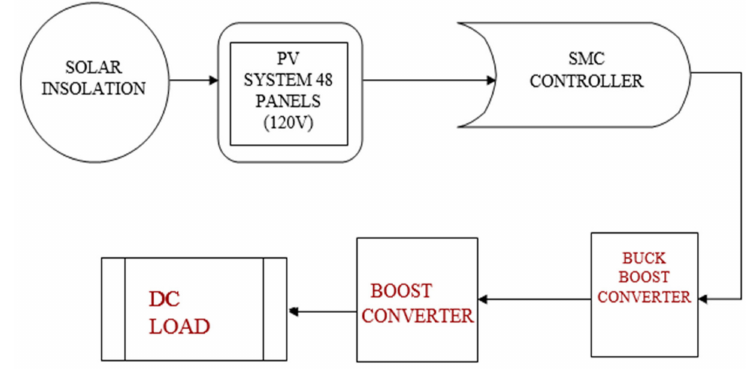
Figure 8. The photovoltaic system coupled with the DC